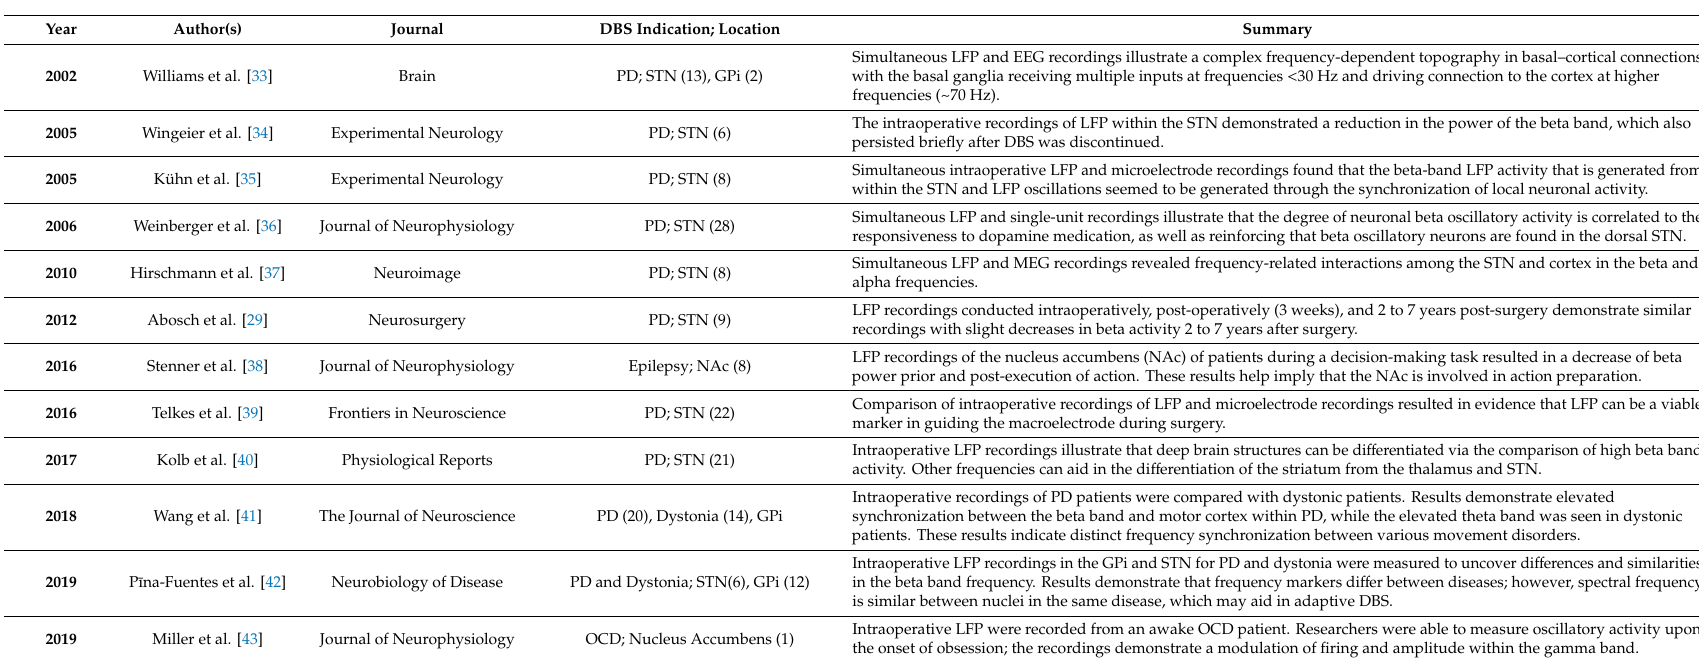
Table 2. Local field potentials (LFP). EEG: